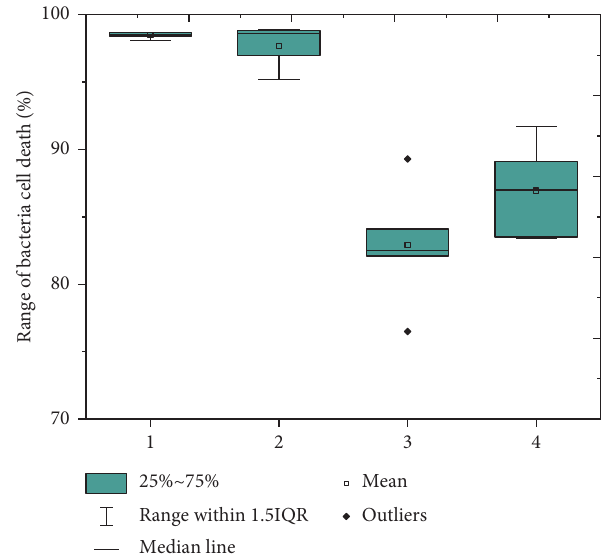
Figure 21: A boxplot of the antibacterial activities of nano- composites (CuO/Ag and ZnO/Ag) against bacteria species. 1 � CuO/Ag against E . coli, 2 � CuO/Ag against S . aureus, 3 � ZnO/ Ag against E. coli , and 4 � ZnO/Ag against S. aureus